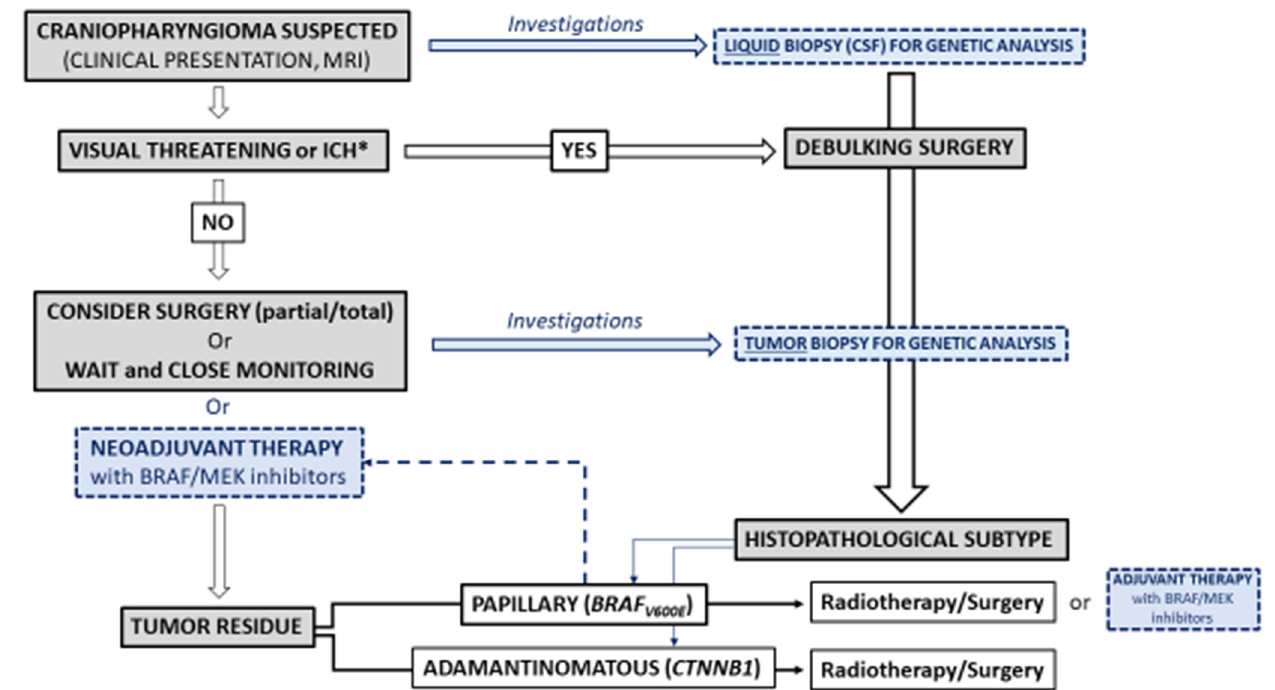
Figure 3. Schematic representation of the current and the new paradigm in the management of craniopharyngiomas (CPs) in adults. In blue and dotted lines, current or incoming investigations in the field of CPs* Intracranial Hypertension.